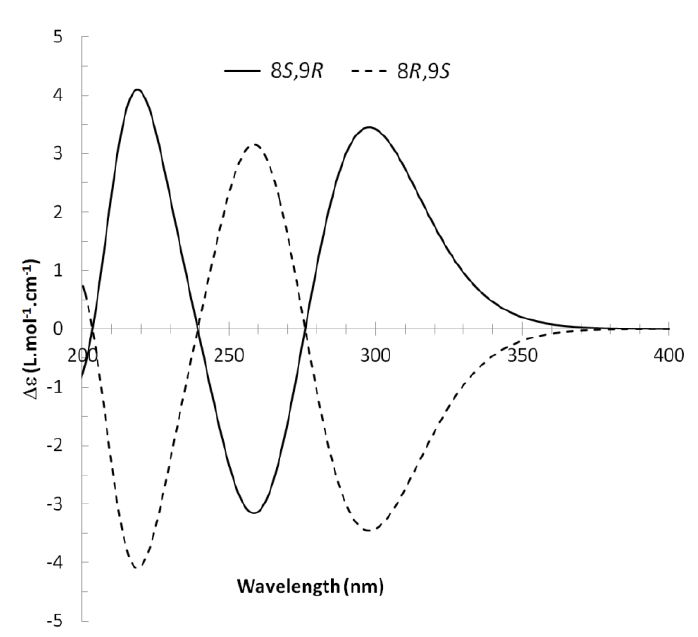
Figure 5. Boltzmann-weighted calculated ECD spectra of 8 R , 9 S and 8 S , 9 R enantiomers of dodovisate C ( 1 ).